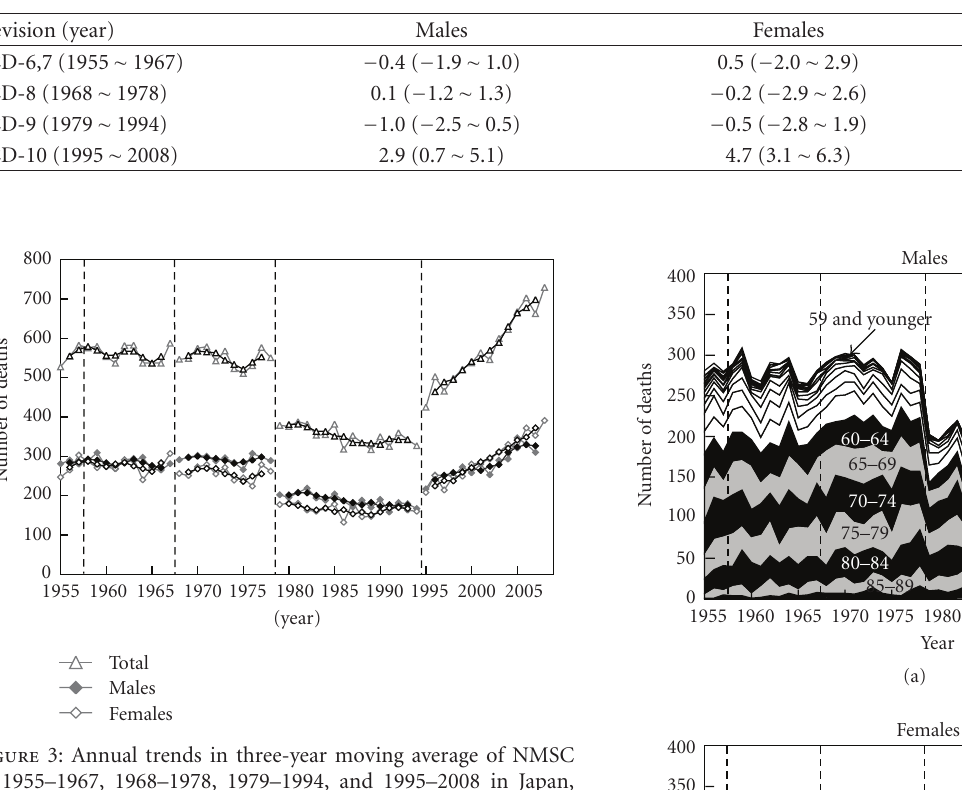
Table 1: The annual increased ratio of deaths from nonmelanoma skin cancer (NMSC) (% and 95% confidence interval) from 3-year moving average by sex in each ICD revision in Japan.